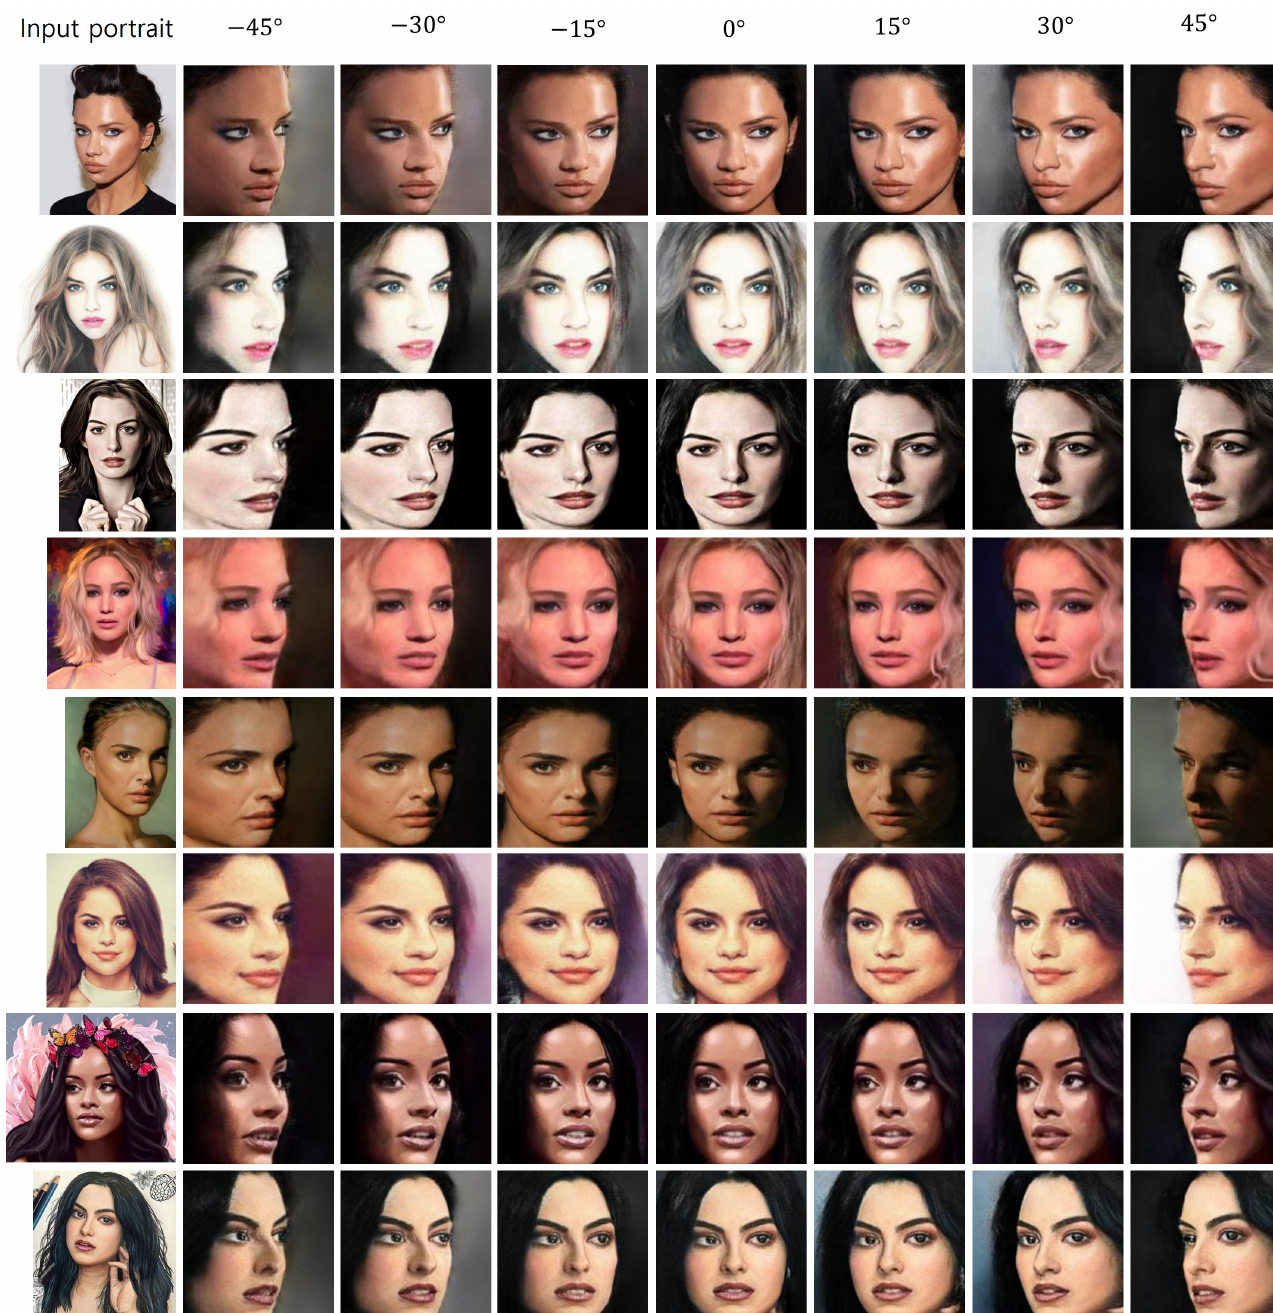
Figure 6. Female portraits from